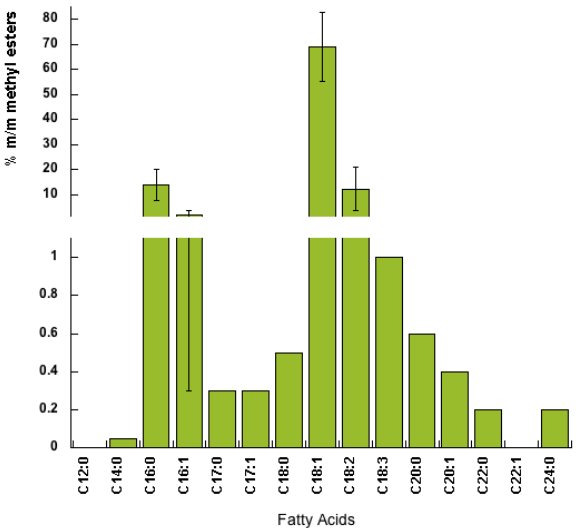
Figure 2. Fatty acid composition determined by gaschromatography (% m/m methyl esters) International Olive Oil Contest (IOOC) (2003).